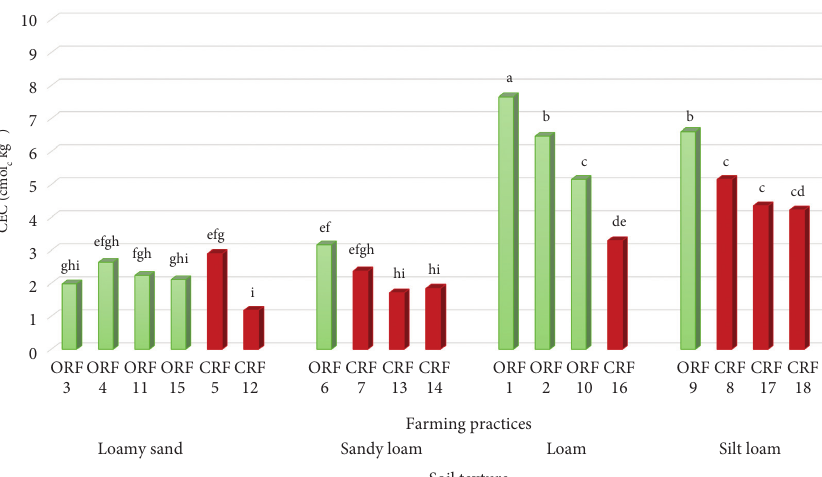
Figure 5: Cation-exchange capacity (CEC) as influenced by soil texture and farming practices. Note: ORF � organic rice farming; CRF � conventional rice farming.